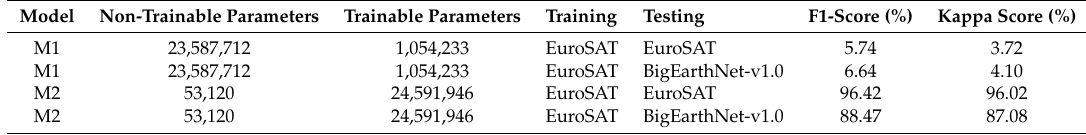
Table 7. Classification accuracy of the adapted ResNet50 models M1 and M2 (100 epochs of training). Model Non-Trainable Parameters Trainable Parameters